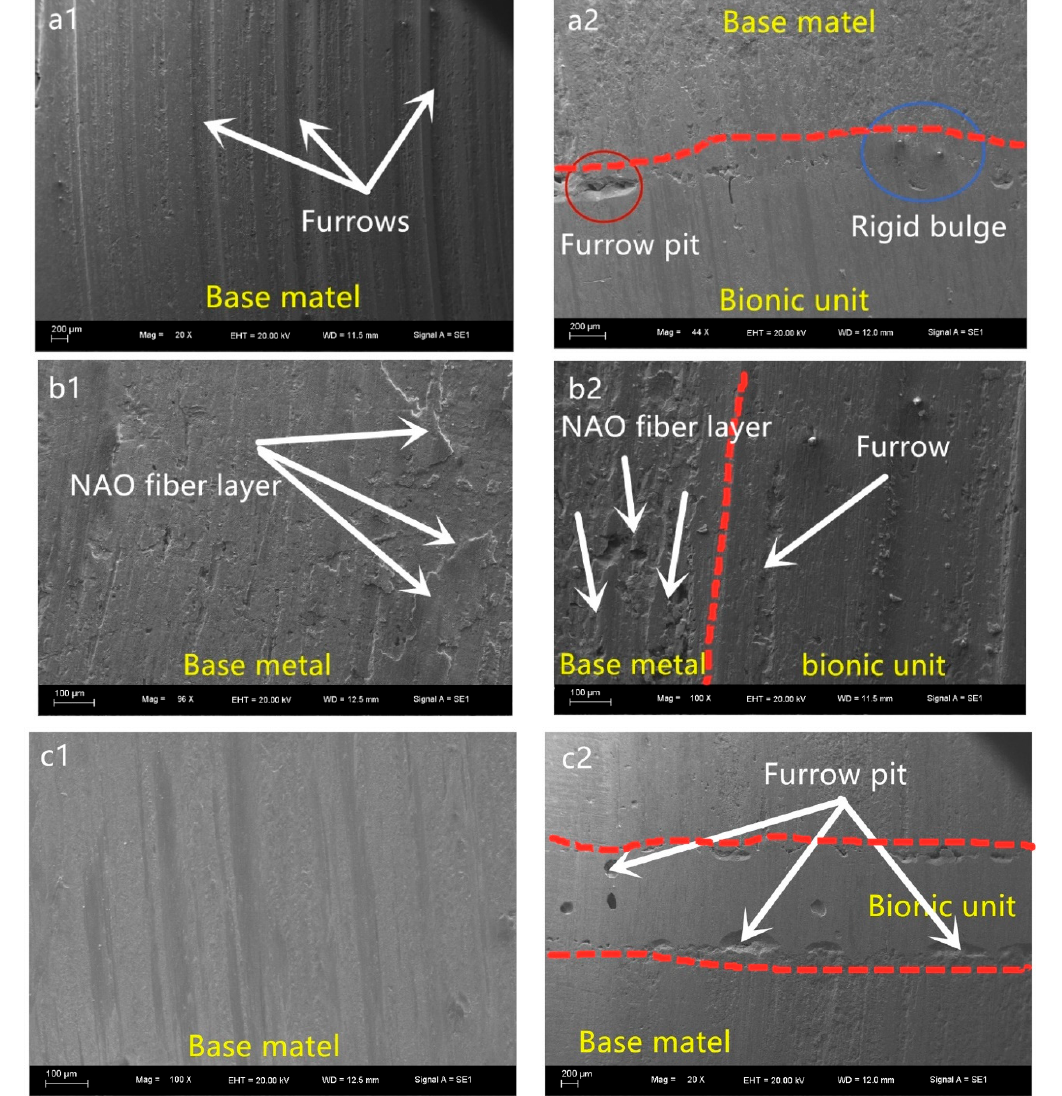
Figure 12. Surface wear morphology of biomimetic samples. ( a1 ) The wear morphology of blank and semi metal brake pads; ( a2 ) the wear morphology of bionic and semi metal brake pads; ( b1 ) the blank specimen and wear morphology of a NAO brake pad; ( b2 ) the bionic specimen and wear morphology of a NAO brake pad; ( c1 ) the wear morphology of blank samples and ceramic brake pads; ( c2 ) the wear morphology of bionic samples and ceramic brake pads.